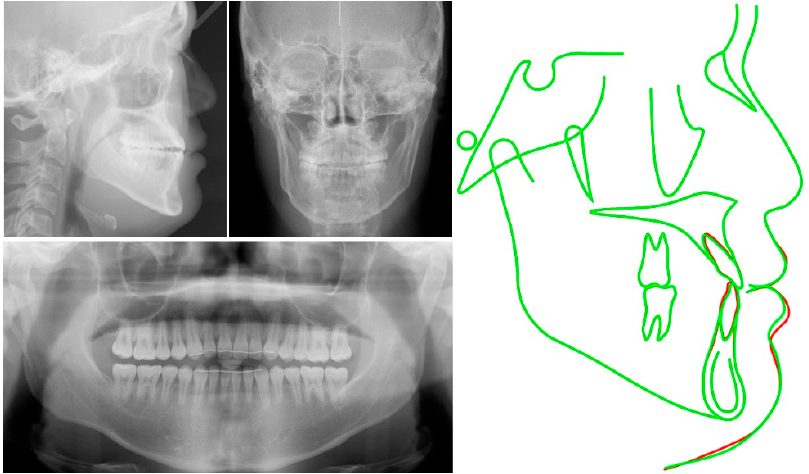
Figure 15. 22-month retention radiographs and cephalometric superimposition. Red, posttreatment; Green, 22-month retention.